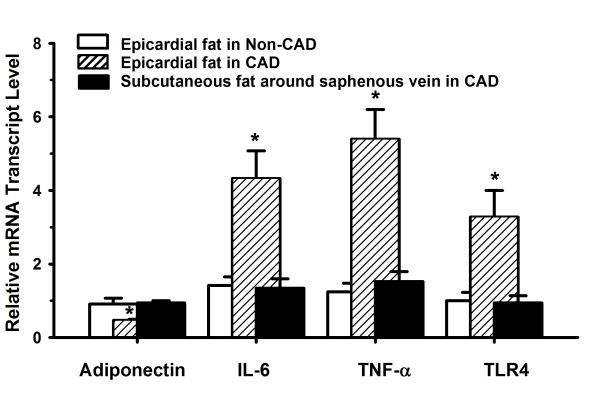
Quantitative comparison of gene expression among adipose tissues. After normalization to β-actin, relative adiponectin, IL-6, TNF-α and TLR4 mRNA transcription level were expressed as compared to pectoral subcutaneous adipose tissue obtained from four patients without heart diseases, which was set equal to 1. Relative adiponectin, IL-6, TNF-α and TLR4 mRNA expression was measured by real time quantitative RT-PCR in different adipose tissues. Results are the mean of triplicate measurements repeated twice. *P < 0.05 vs epicardial fat in non-CAD patients and subcutaneous fat around greater saphenous vein in CAD patients. Abbreviations: IL-6, interleukin-6; TNF-α, tumor necrosis factor-α; TLR-4, toll-like receptor 4; CAD, coronary artery disease.